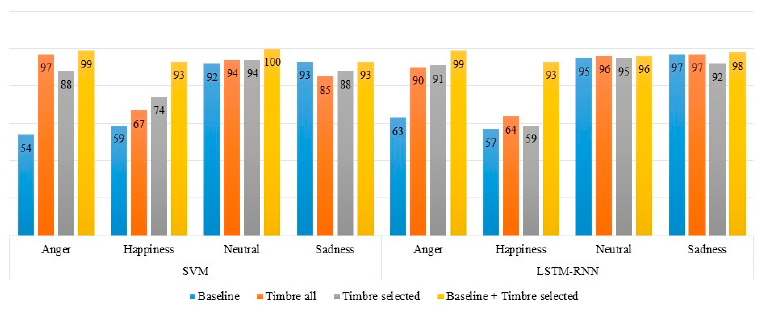
Figure 5. Recognition rates for discrete emotions on baseline, timbre all, timbre selected, and the combination of baseline and timbre selected acoustic features for EMO-DB. Table 6. Comparison of the results in literature with the proposed acoustic feature set for EMO-DB.